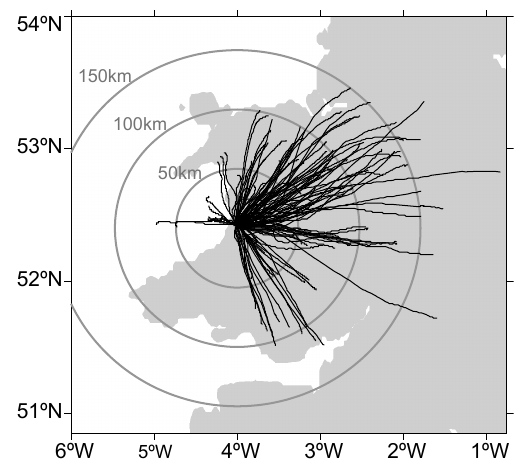
Figure 4. Flight tracks of 127 radiosondes launched from the Aberystwyth radar site. The grey shading indicates the land surface, and 50km range intervals are shown by the concentric grey circles centred on the radar site. Only the first 21km of sonde ascent are shown, corresponding to the upper altitude limit of the MST